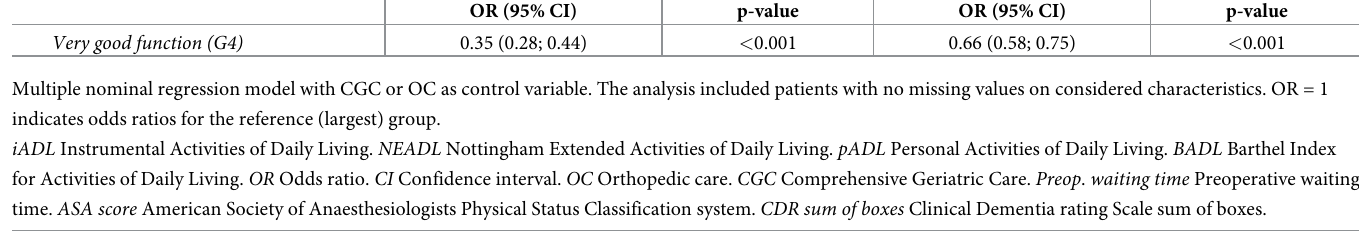
In this longitudinal cohort of 726 older adults we studied functional decline one year after hip fracture. The statistical analyses identified four groups following distinct trajectories for both iADL and pADL. For both iADL and pADL, most trajectories did not regain their pre-fracture ADL levels. Overall, younger age, an ASA score of 1 or 2, and lower CDR score were all associ- ated with belonging to groups with higher ADL and better trajectories. We also identified a group of patients for both iADL and pADL with relatively good pre-fracture function, but with a steep decline in ADL function the first four months after the fracture. This decline remained